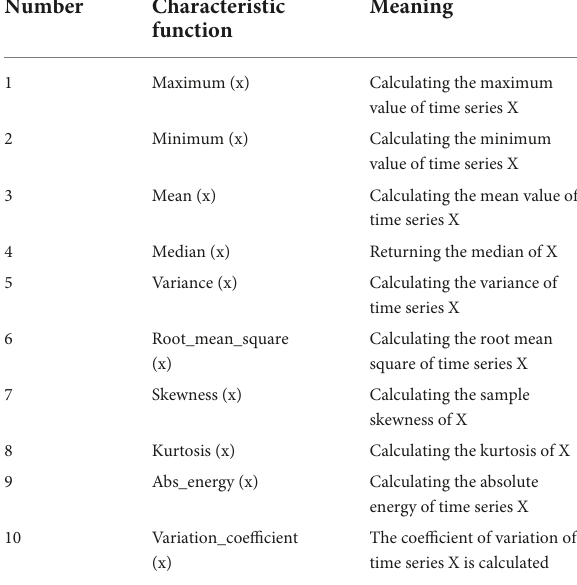
TABLE 3 The 10 time-domain feature extraction indicators used in the